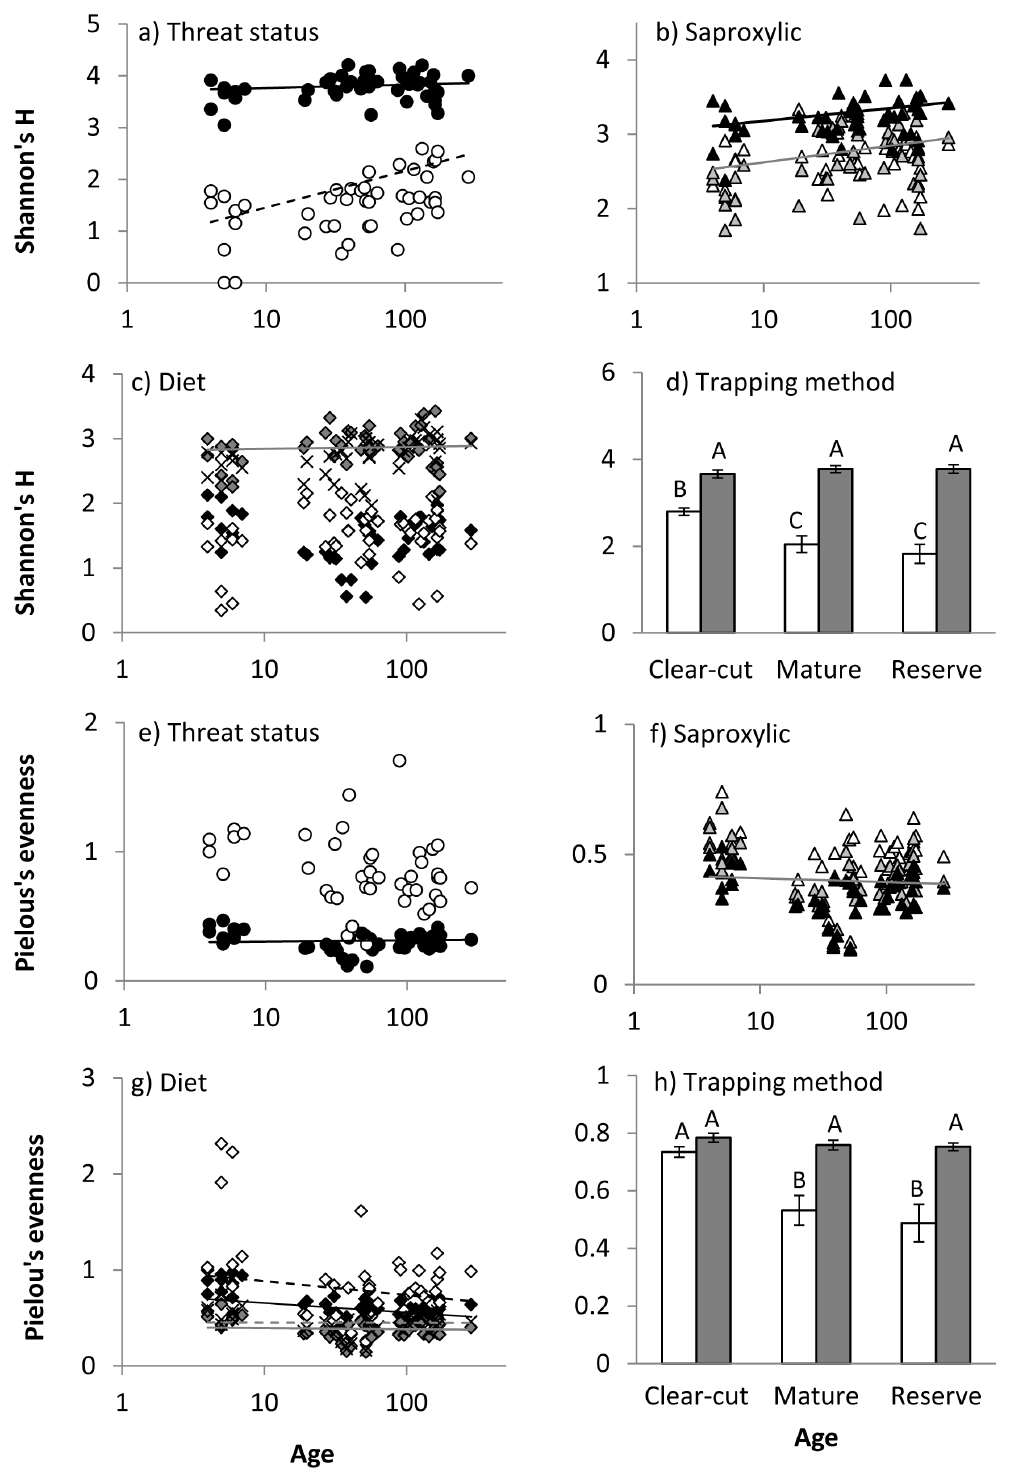
Figure 2. Relationships between stand age and Shannon’s H and stand age and Pielou’s evenness index for beetle functional groups based on: a) and e) threat status; b) and f) degree to which species are dependent on dead wood; c) and g) diet; and d) and h) trapping method. Symbols as for Figure 1. Only significant or near-significant regression lines are shown. Lines may appear curved due to the log scale of the y-axis. doi: 10.1371/journal.pone.0072764.g002 PLOS ONE |